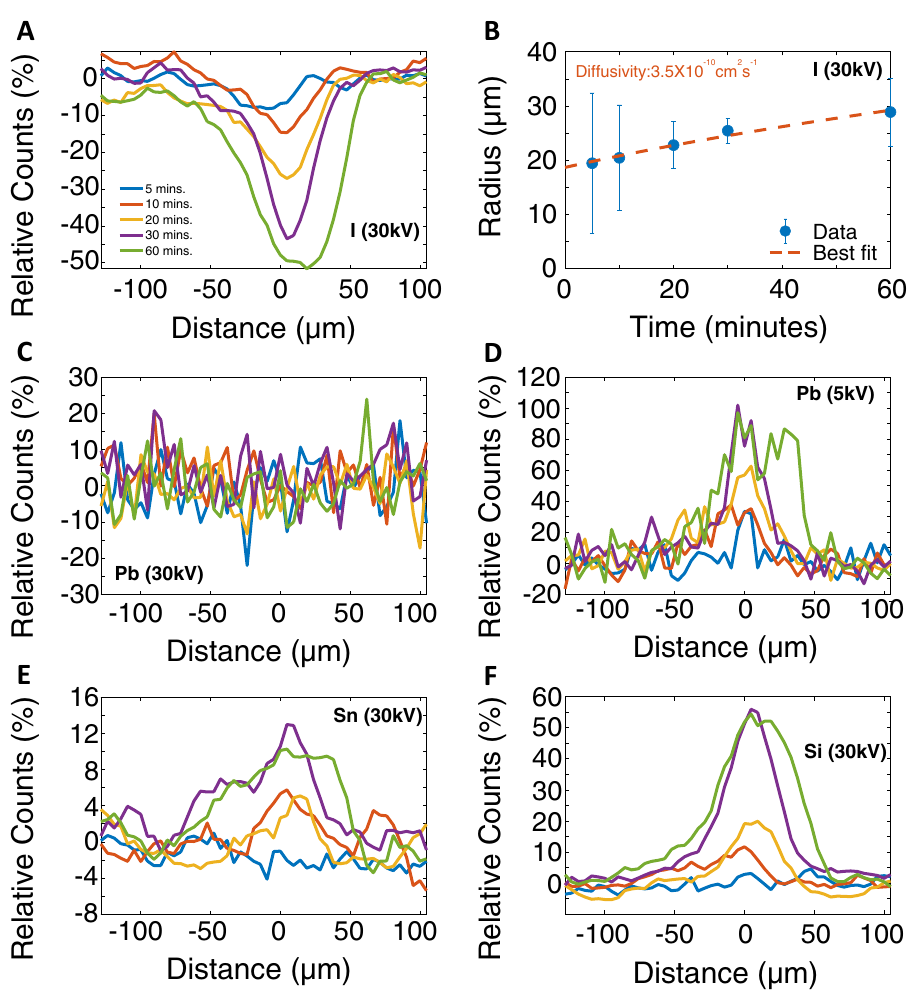
Fig. 3 | EDS elemental analysis of FAPbI 3 after optical exposure. An optical fl uenceof~106.6 μ Jcm − 2 wasusedforthisdataset. A ThechangeintheX-raycounts corresponding to iodine as probed by 30-keV PEs. The change in counts was cal- culated relative to the value measured from pristine areas without light exposure. B The corresponding fi tted radii of the iodine de fi ciency distributions versus the